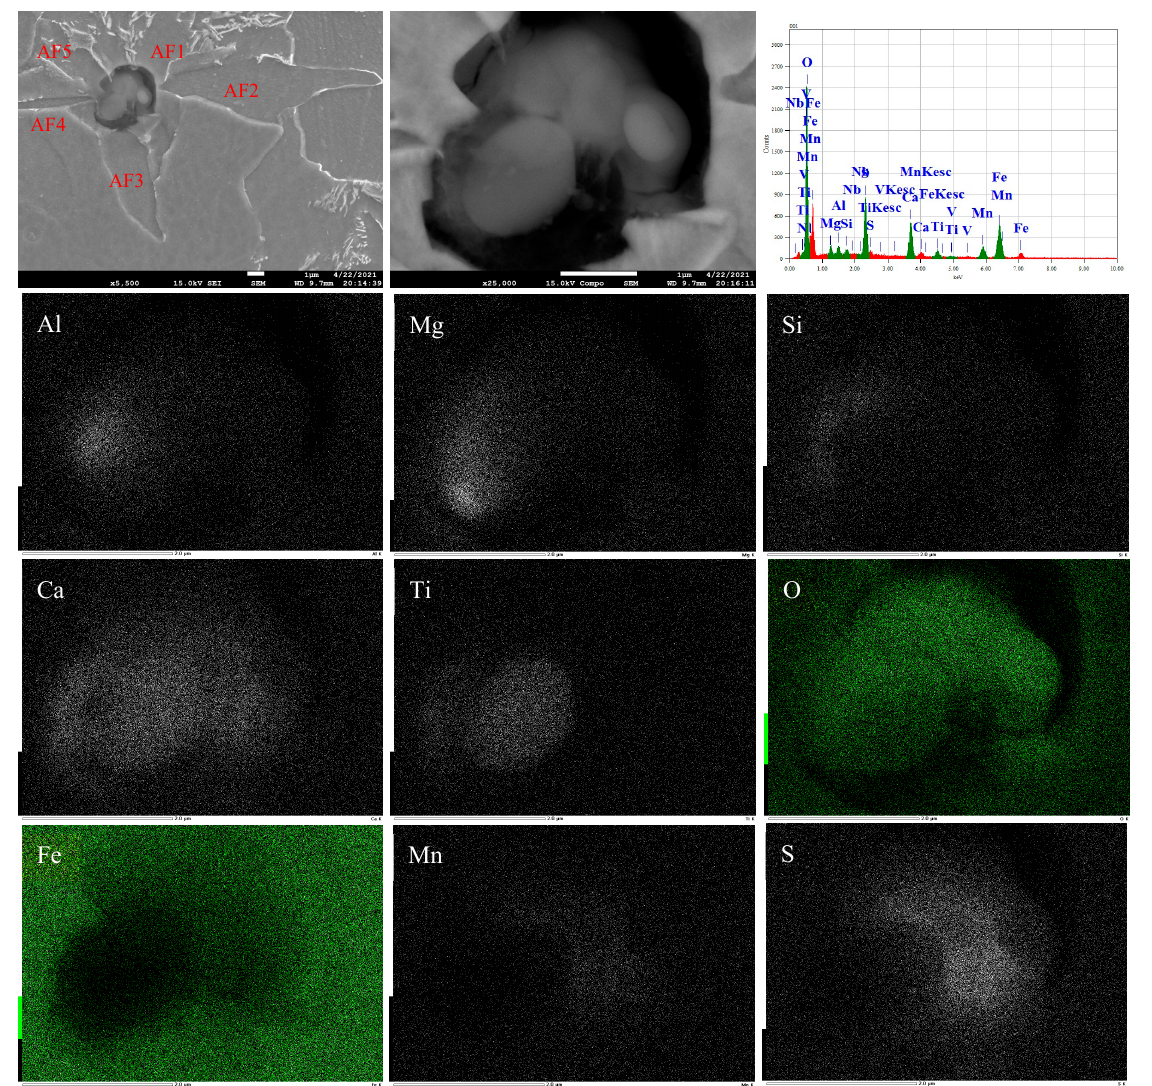
Figure 19. EDS mapping analysis of one typical inclusion C effective for IAF nucleation in Ti-Ca deoxidized steel .